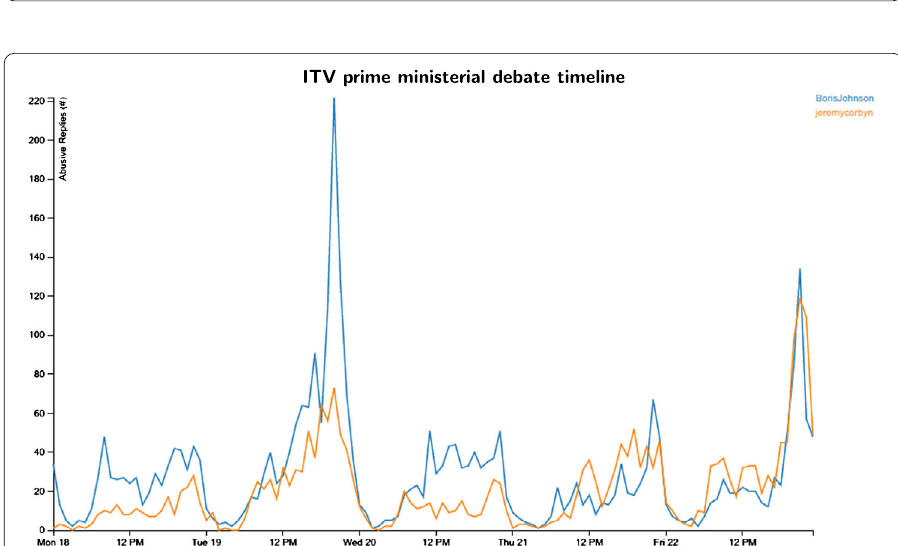
Figure 5 ITV prime ministerial debate timeline. Per-hour timeline for the two participants covering the days surrounding the November 19th ITV prime ministerial